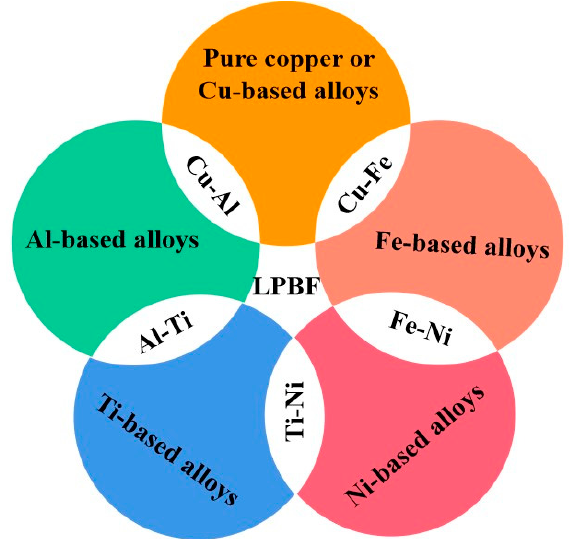
Figure 2. The classification schematic of LPBF-processed dissimilar metal materials.